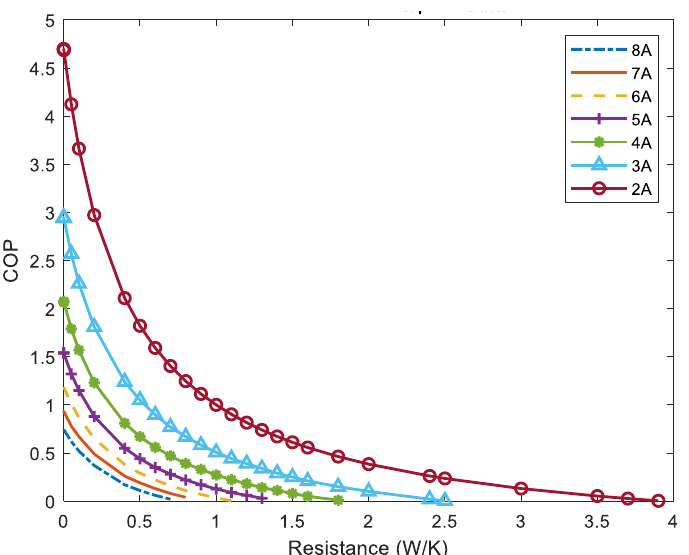
Figure 7. Variation of COP with a thermal resistance of the two sides of the TE module.